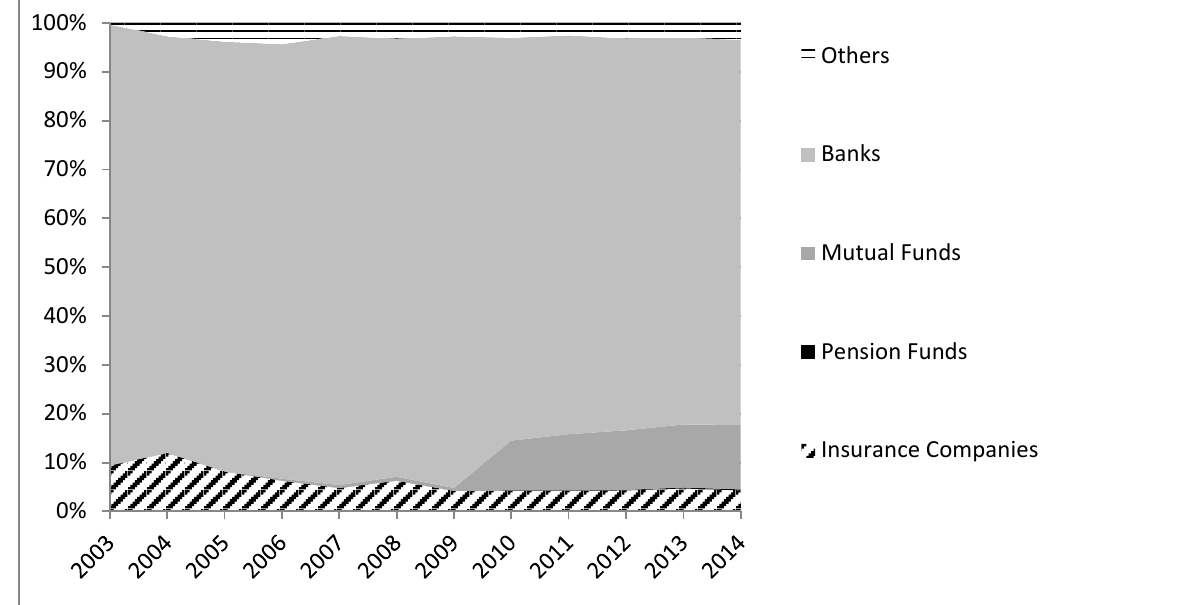
Fig. 1. Distribution of financial assets by the main types of financial institutes in